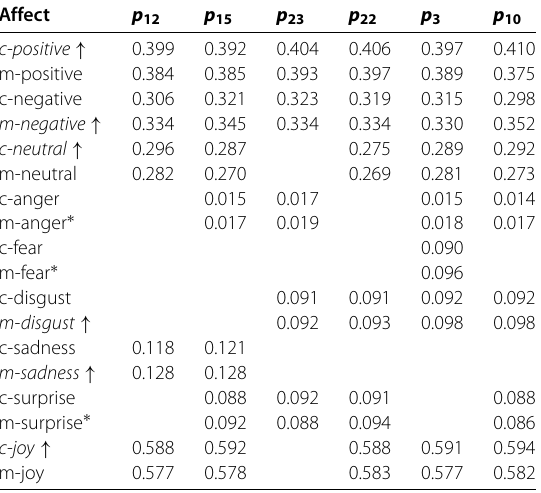
Table 4 Differences in emotion and sentiment proportions between military (m-) and control (c-) populations